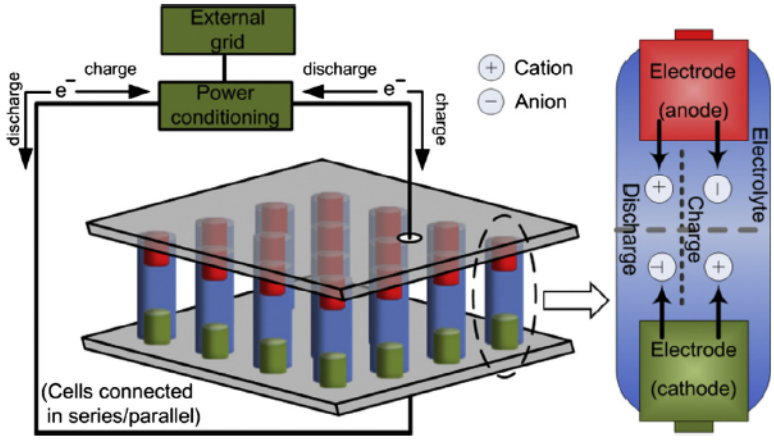
Figure 1. Schematic diagram illustrating the operation of a battery system [16].